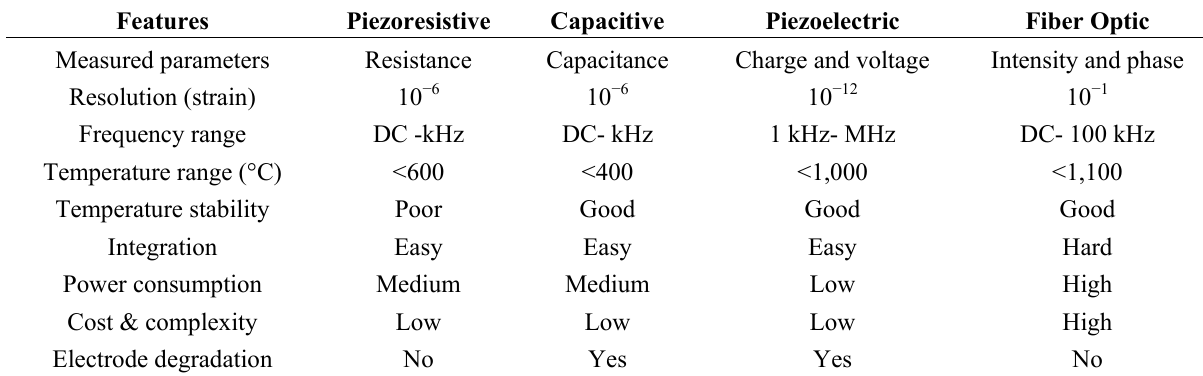
Table 1. Key features of existing high-temperature sensors